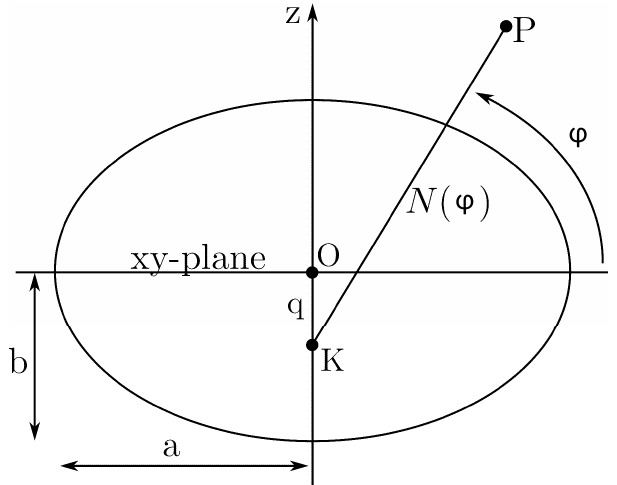
Figure 2. Distance q from the center of ellipsoid to the intersection of the normal to the ellipsoid at the receiver position. Meridian cross section at the observation point.